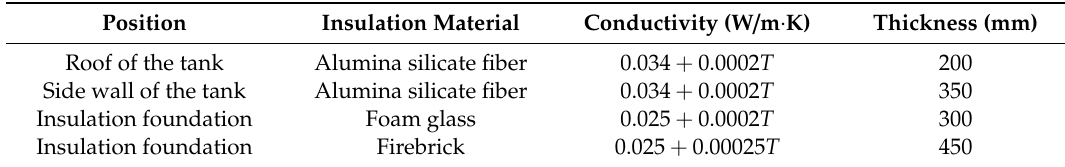
Table 2. Properties of the insulation materials.